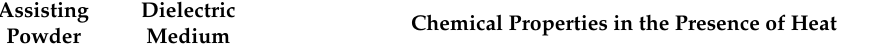
Table 3. The analytical chemical composition of erosion products and the subsurface layer of the processing surface during electrical erosion of some ceramics using a brass or copper electrode tool